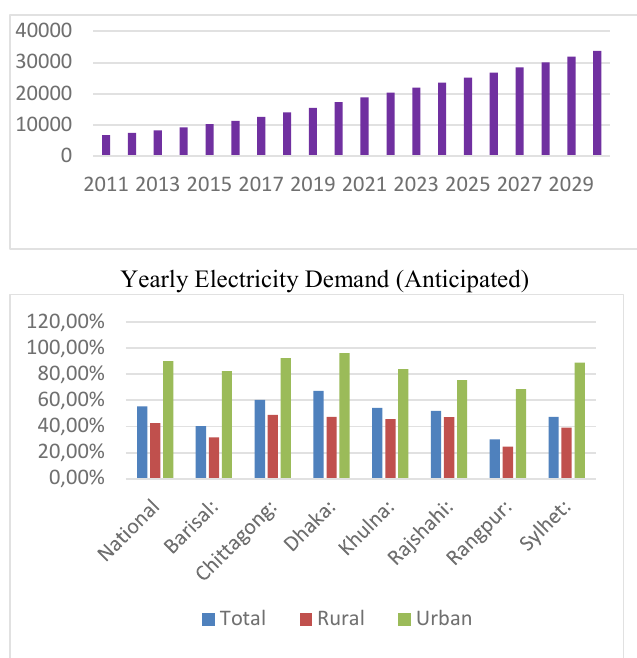
Figure 3: Electrification Rate in Different